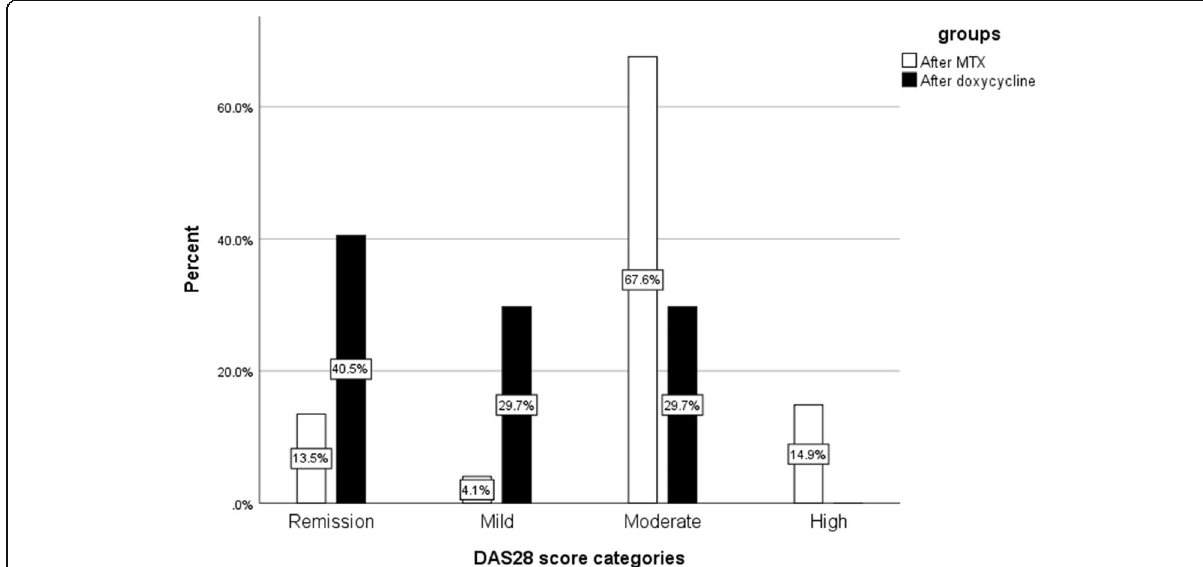
Fig. 2 Percentages of patients in different DAS28-CRP categories after treatment in both the two groups (patients treated with MTX and patients treated with MTX and